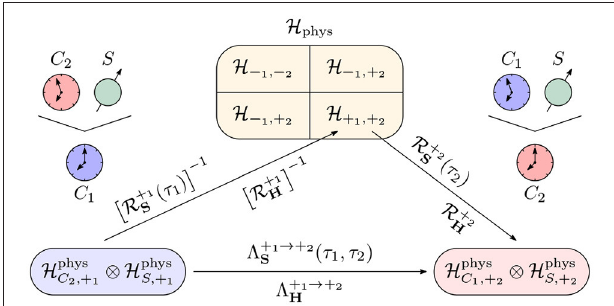
FIGURE 3 | Schematic representation of a temporal frame change, as defined through Equation (68). The figure encompasses both the relational Schrödinger picture of the Page-Wotters formalism and the relational Heisenberg picture of the quantum deparametrization (as well as their mixtures). Viewing the reduction maps R + i I as quantum coordinate maps, any such temporal frame change takes the form of a quantum coordinate transformation from the description relative to clock C 1 to the one relative to clock C 2 . Just as coordinate transformation pass through the reference-frame-neutral manifold, the quantum coordinate transformations pass through the clock-neutral physical Hilbert space in line with the general discussion of the clock-neutral structure and quantum general covariance in section 2. Due to the double superselection rule, the quantum coordinate transformations have to preserve the overlaps of the frequency sectors of C 1 and C 2 . Here we illustrate the example of the overlap of the positive frequency sectors of both clocks, so that the corresponding frame transformation passes through H (cf. Equation + 1 , + 2